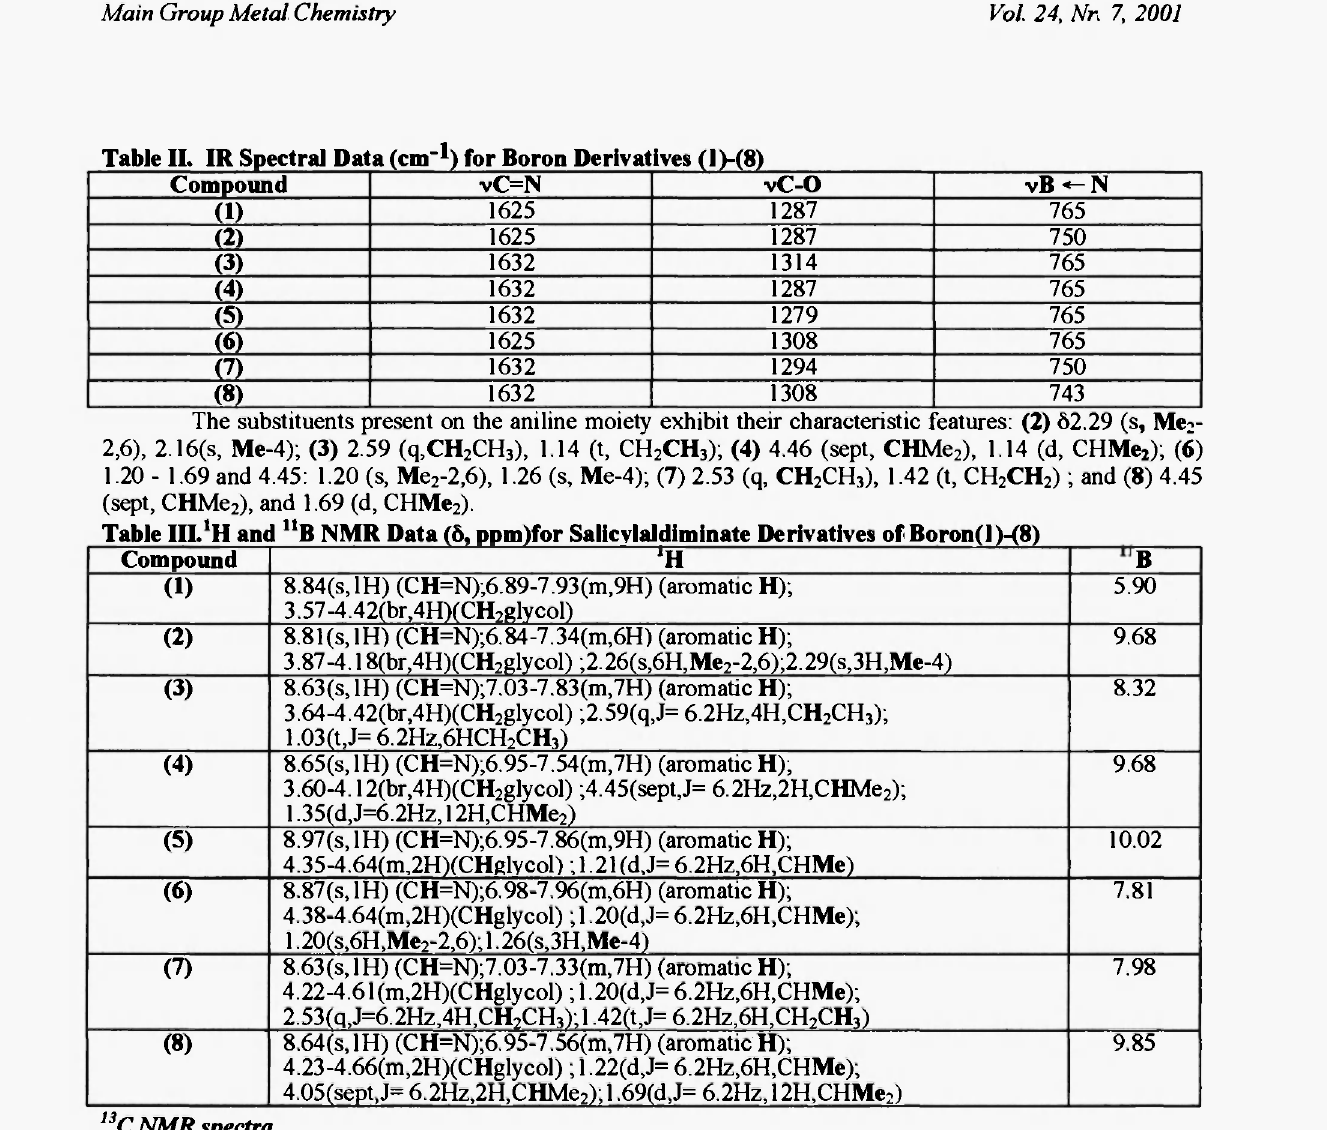
Table II. IR Spectral Data (cm' 1 ) for Boron Derivatives (l)-(8) Compound